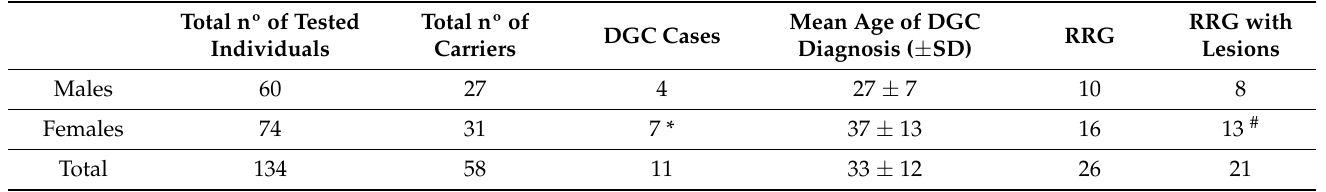
Table 1. Overview of stomach-related clinical presentations in CDH1 c.1901C>T variant carriers from nine HDGC families. Total nº of Tested